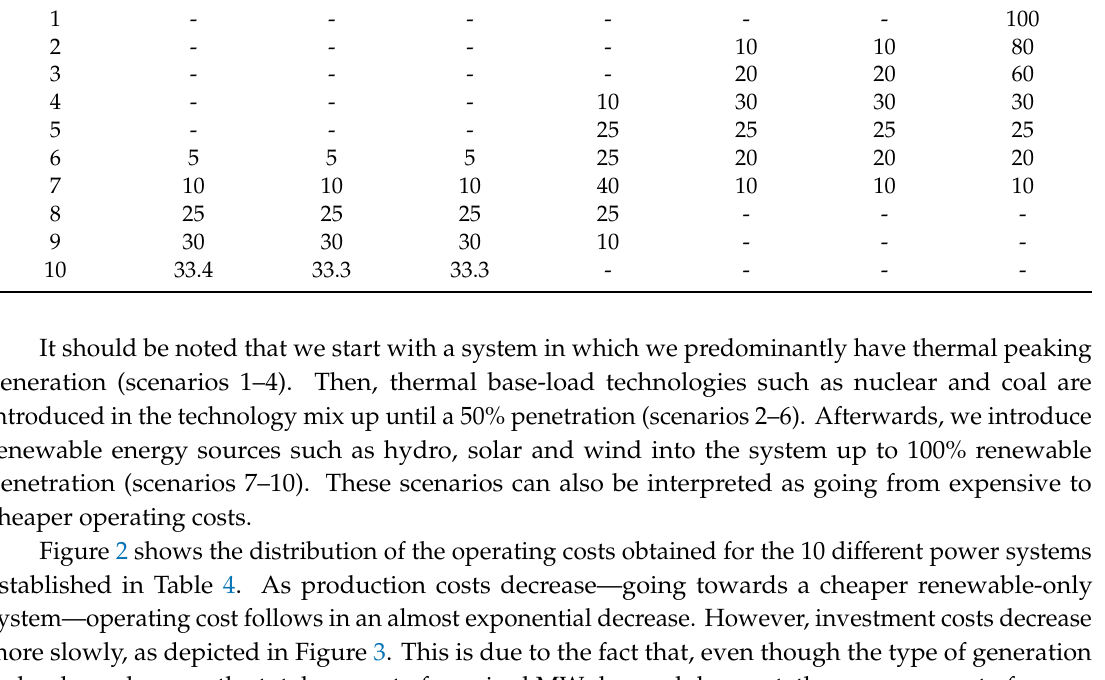
Table 4. Percentage of capacity penetration of each technology for each of the scenarios. Scenario %